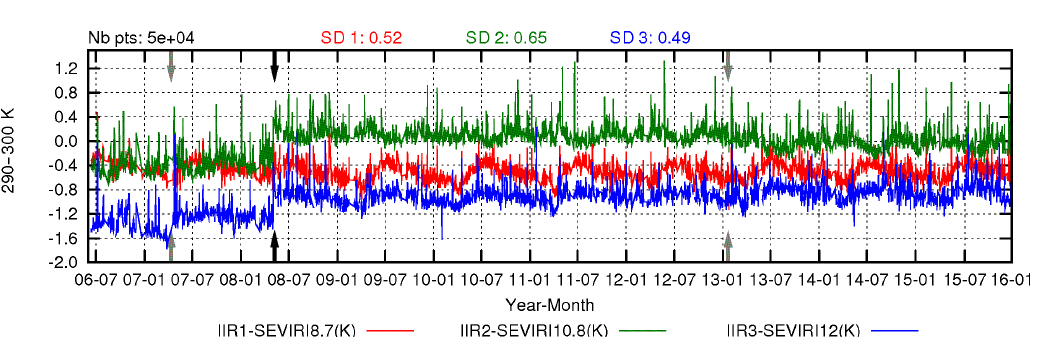
Figure 7. Same as Fig. 6 but at 60–82 ◦ N.